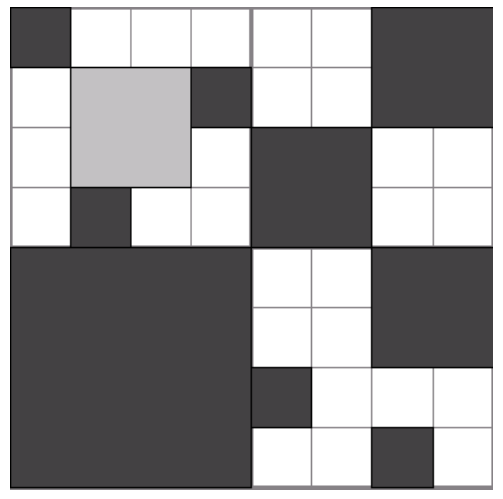
Figure 17. Global partitioning of the area [48].